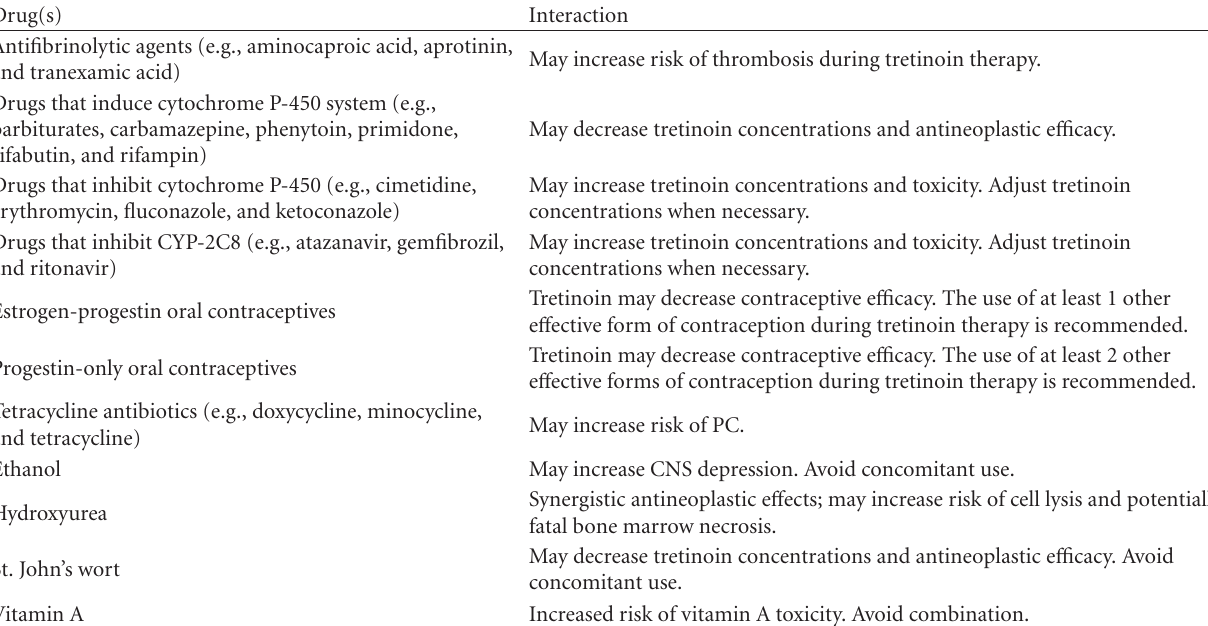
Table 3: Common drug interactions with tretinoin